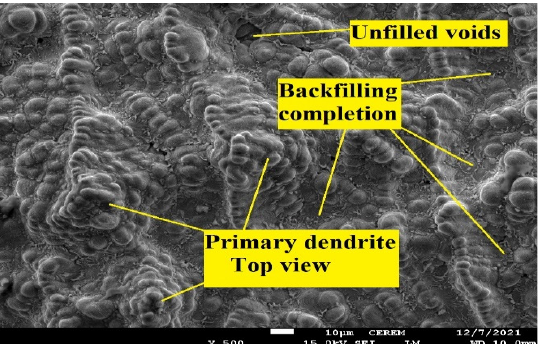
Figure 12. SEM micrograph of solidification hot cracking face in TIG weld coated by pure Nb pow- der (×500).